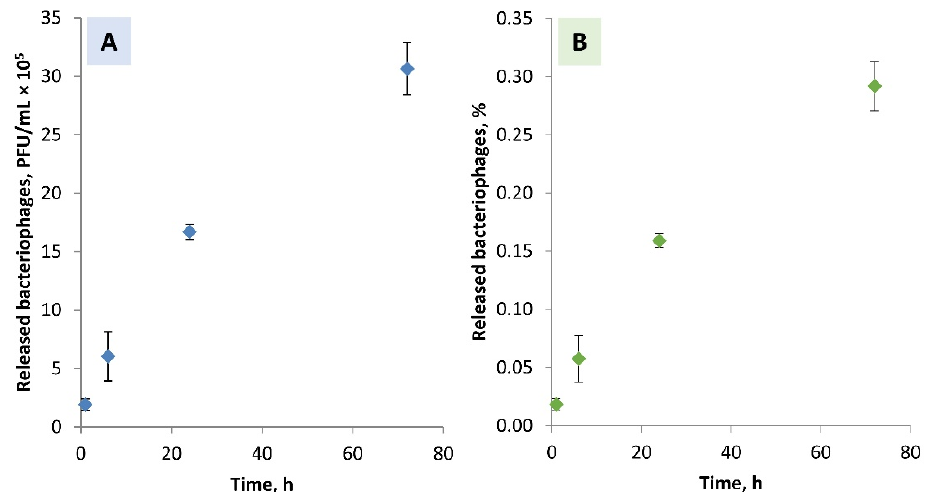
Figure 7. The cumulative amount of the Pyo bacteriophages released from the Ca-alginate hydrogel in the TRIS-HCl buffer (( A )—PFU/mL and ( B )—% from the determined amount of the bacteriophages ((2.1 ± 0.2) × 10 8 PFU/mL) in the Ca-alginate hydrogel).